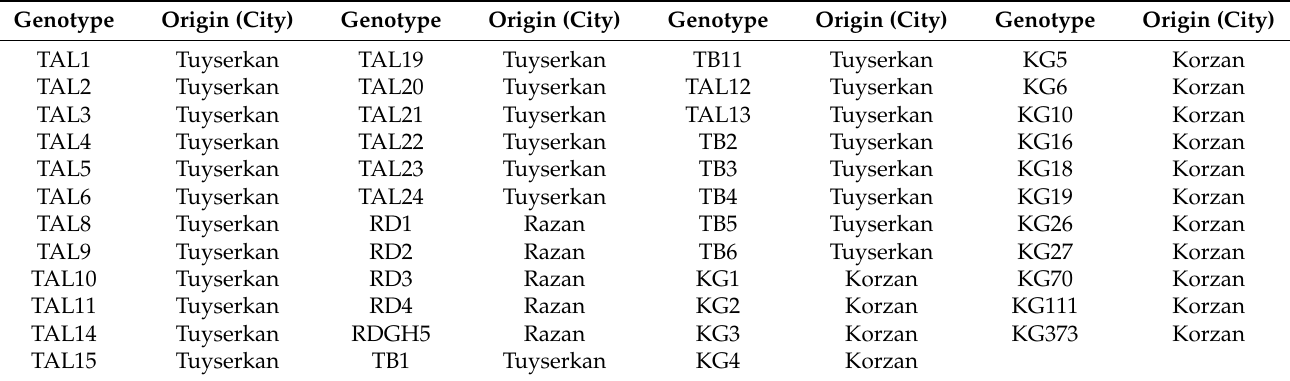
Table 2. Names and origins of the 47 walnut accessions evaluated in this study.